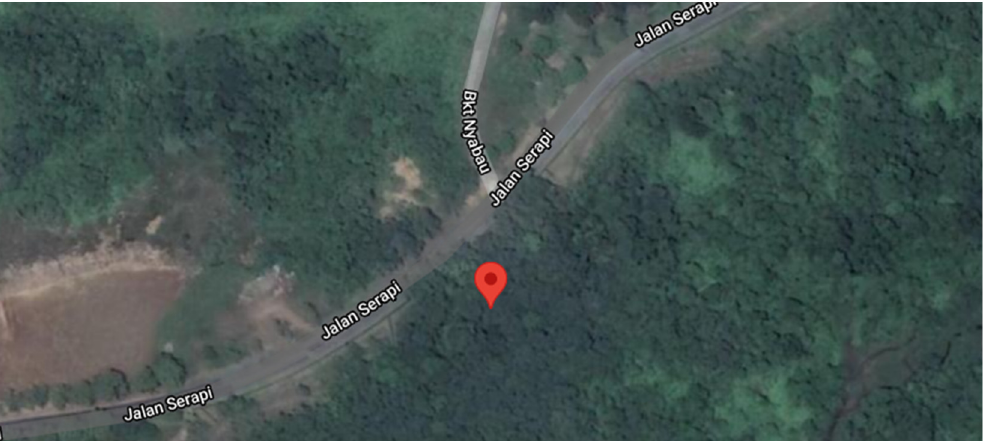
Figure 1. Aerial view of location where soil sampled for this study in Universiti Putra Malaysia Bintulu Sarawak Campus, Malaysia.